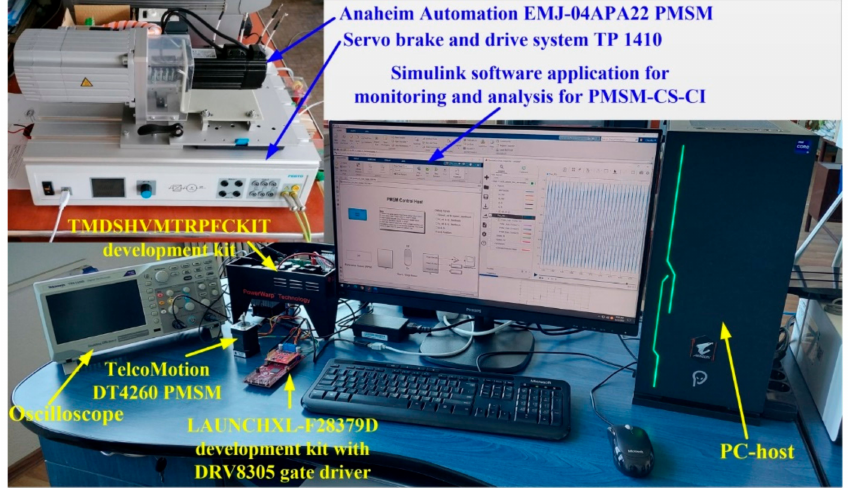
Figure 29. Experimental setup for testing the